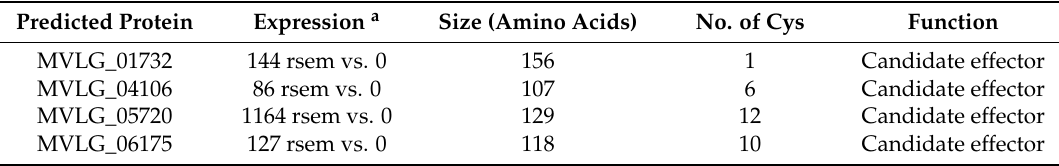
Table 1. Candidate SSPs chosen for further analyses.